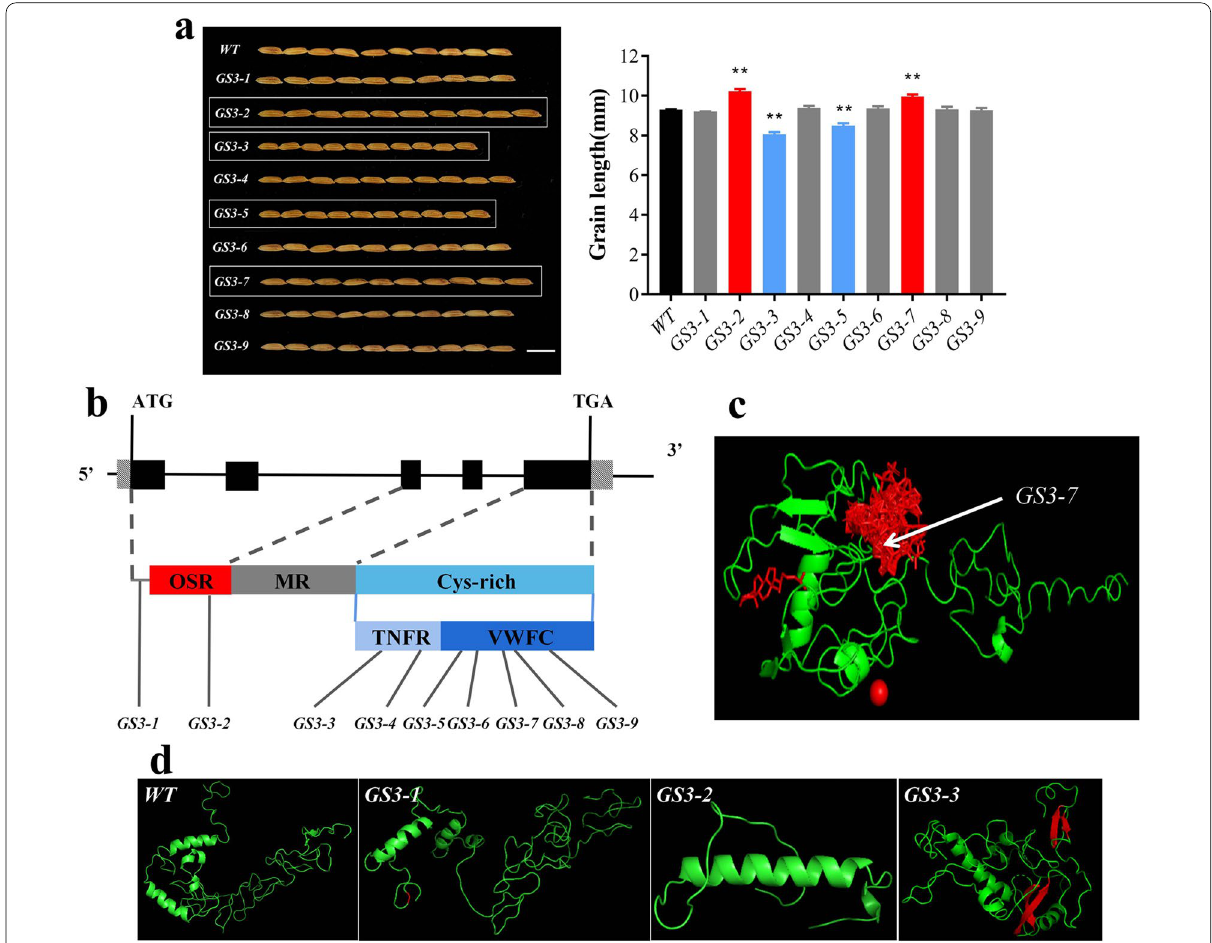
Fig. 5 a Grain length and WT alignment of nine GS3 mutants. Scale bars functional site (red part). d Protein structures of GS3 mutants (differential structures in